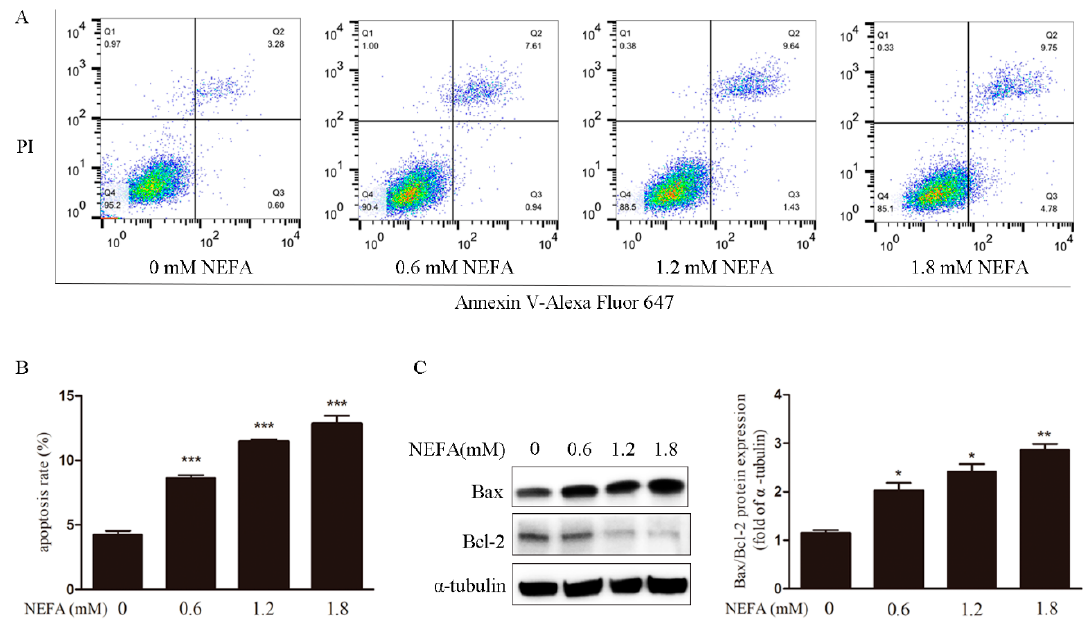
Figure 2. NEFA causes apoptosis in GCs. ( A , B ) The percentage of cell apoptosis was determined by Annexin V-Alexa Fluor 647 / PI staining and FACS. The results shown are representative of at least three independent experiments. ( C ) The protein level of Bax and Bcl-2 were determined by western blot. The results showed that NEFA-induced apoptosis in GCs. Data are presented as mean ± SEM, * p < 0.05, ** p < 0.01, and *** p < 0.001 .